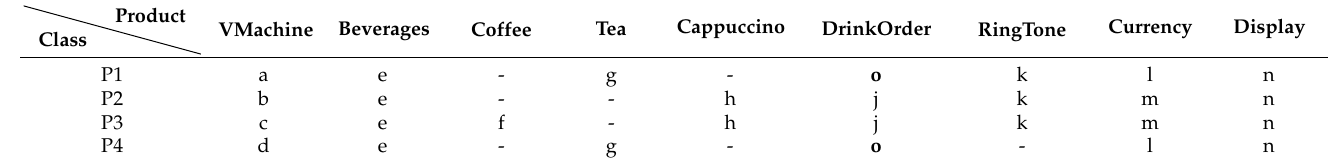
Table 8. The checksum matrix for SPL V1 . Checksum values changed in SPL V0 are presented as bold type.